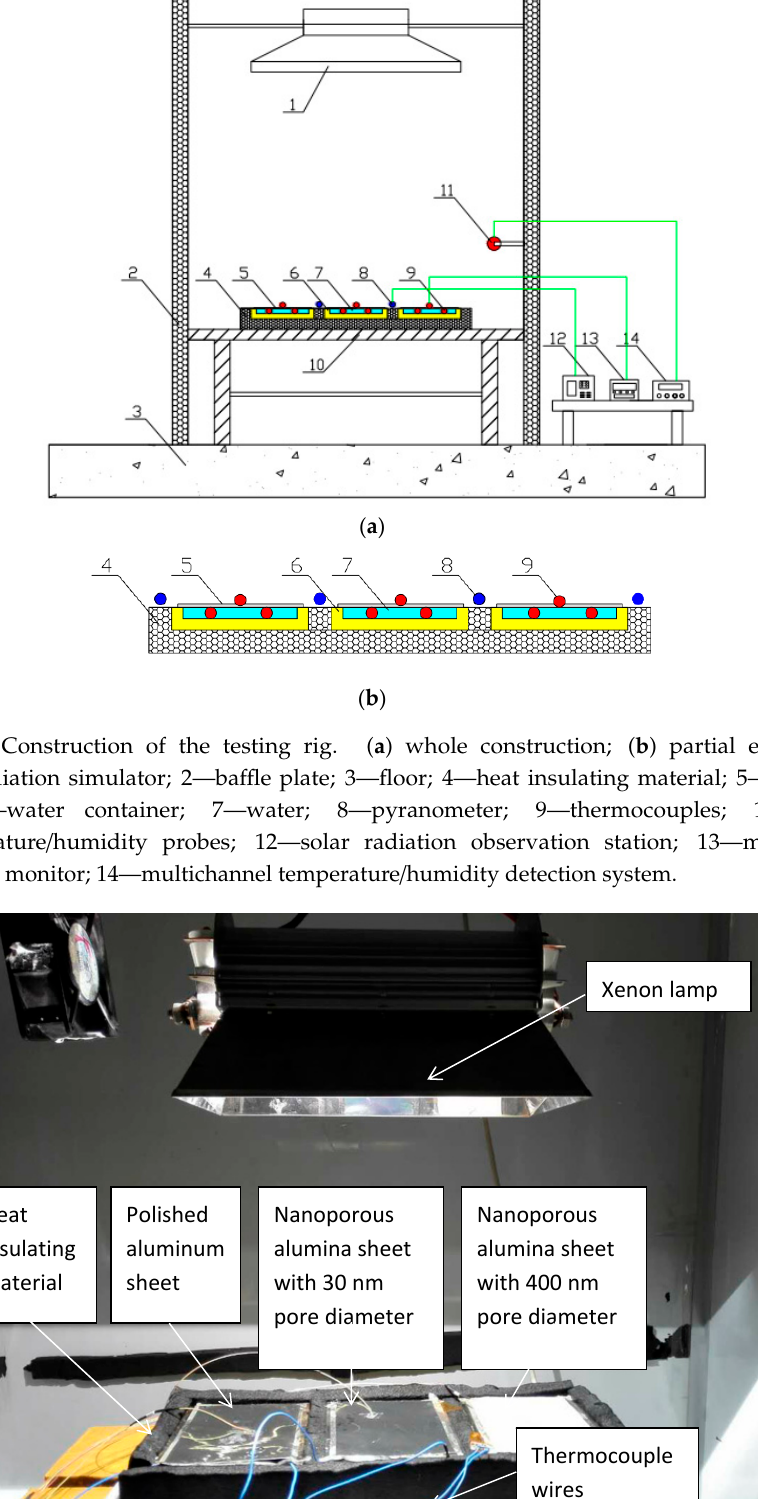
Table 1. Performance parameters of the testing devices. Testing Device